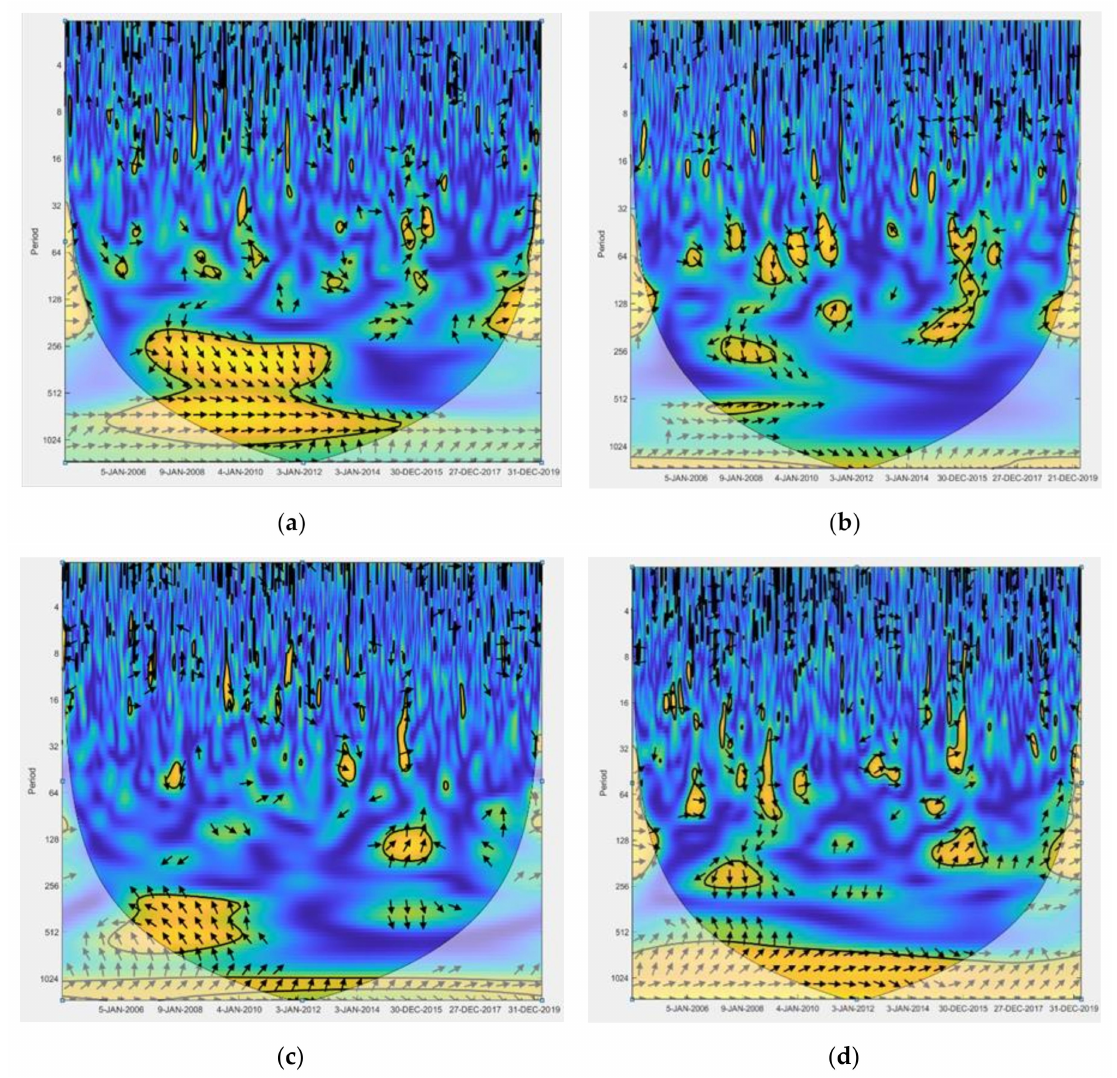
Figure 2. The co-movement between the oil and stock markets in time-frequency space. ( a ) The US stock market, SP500; ( b ) the Japanese stock market, N225; ( c ) the mainland China’s stock market, SSEC; ( d ) the Hong Kong’s stock market, HSI. The area a ff ected by edge e ff ects is the semi-transparent region at the left and right boundary separated by the black U-shaped curve, which is the cone of influence (CoI). The thick black contours within CoI are the regions of significant coherence (at 5% level calculated using an 1000 Monte Carlo simulation). Abbreviations: SP500, S&P 500; N225, Nikkei 225 Index; SSEC, Shanghai Stock Exchange Composite Index; HIS, Hang Seng